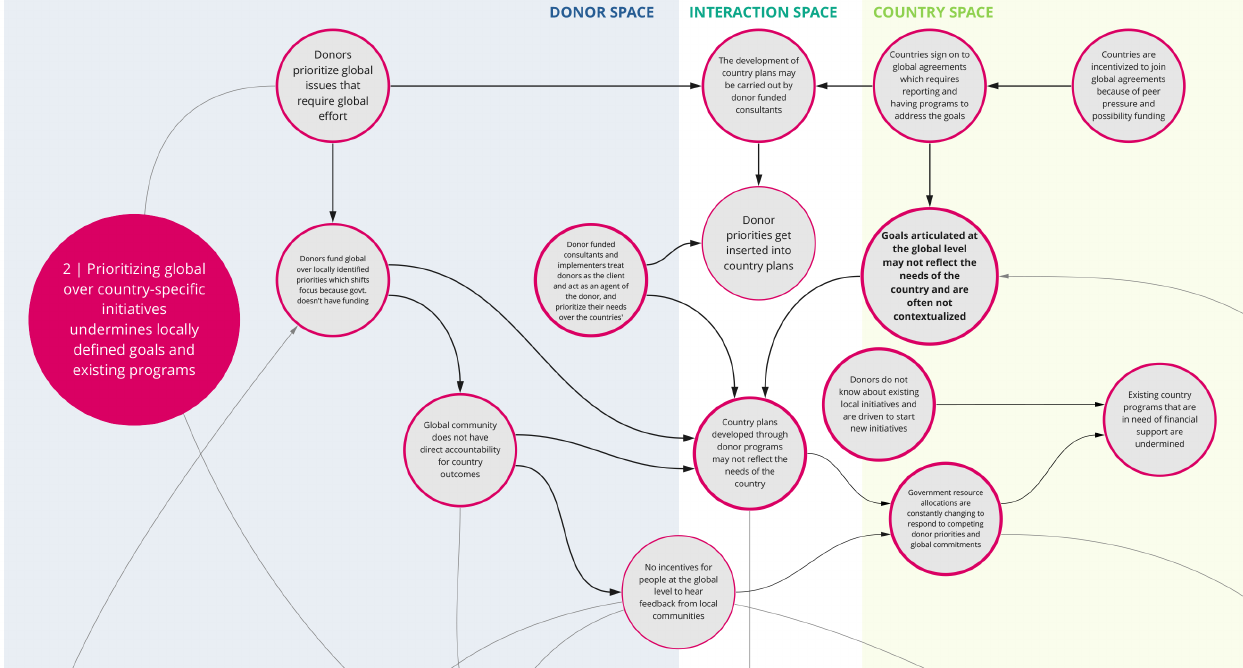
Figure 3. Syndrome 2: Prioritizing global over country-specific initiatives undermines locally defined goals and existing